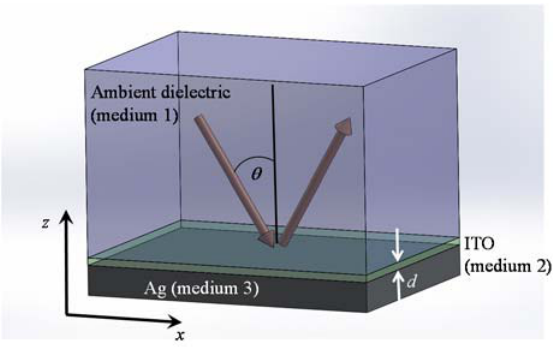
Figure 8. The illustration of the multilayer HMM resonator on top of Ag substrate ( a ) and enhancement of power emitted relative to the power of the same dipole radiated in free-space ( b ). Reprinted with permission from [25]. Copyright 2014, AIP Publishing LLC.